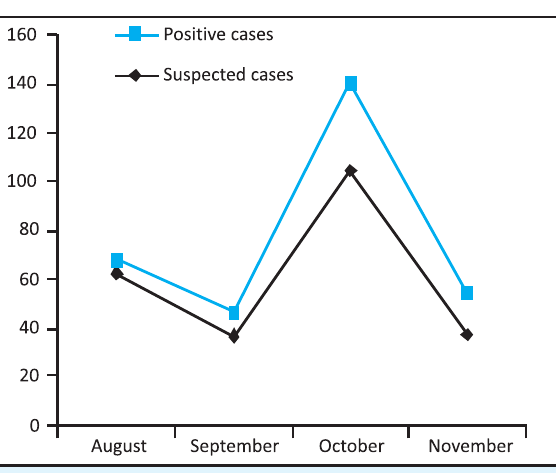
Figure 1. Month wise distribution of dengue